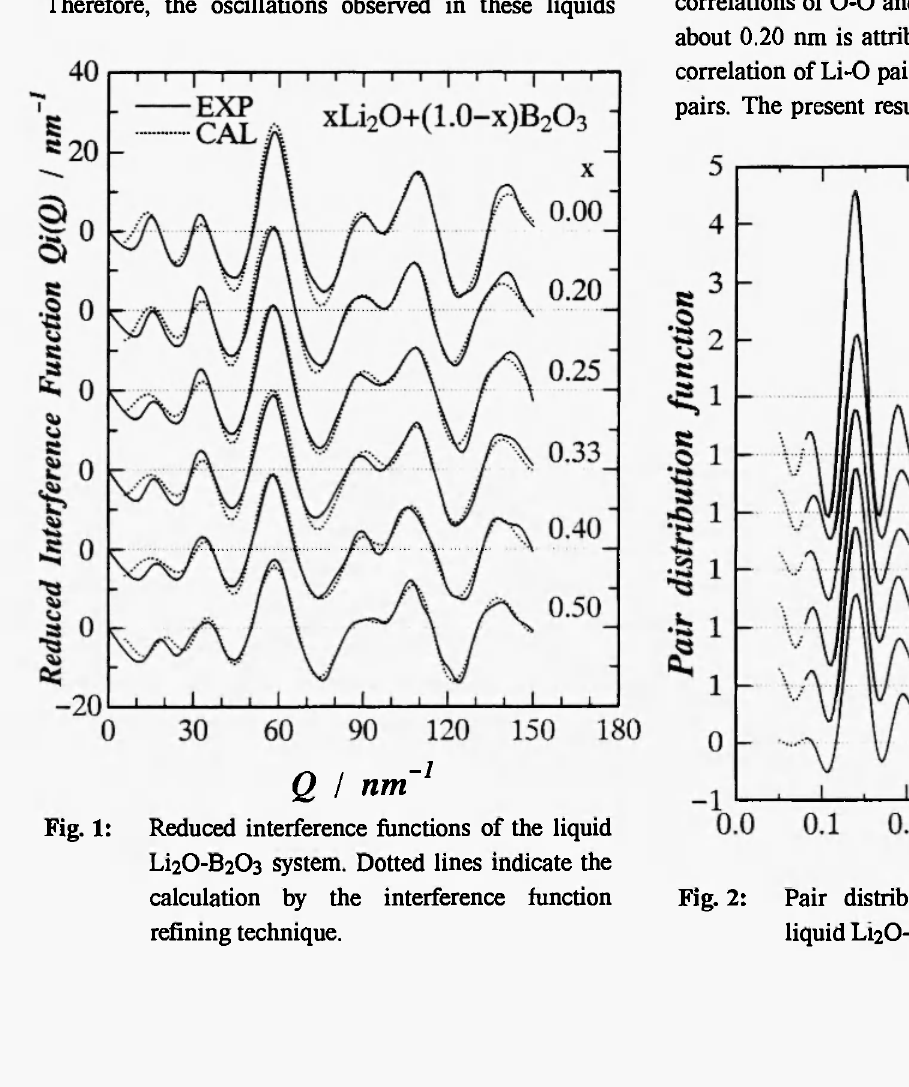
Fig. 2: Pair distribution functions (PDFs) of the liquid L12O-B2O3